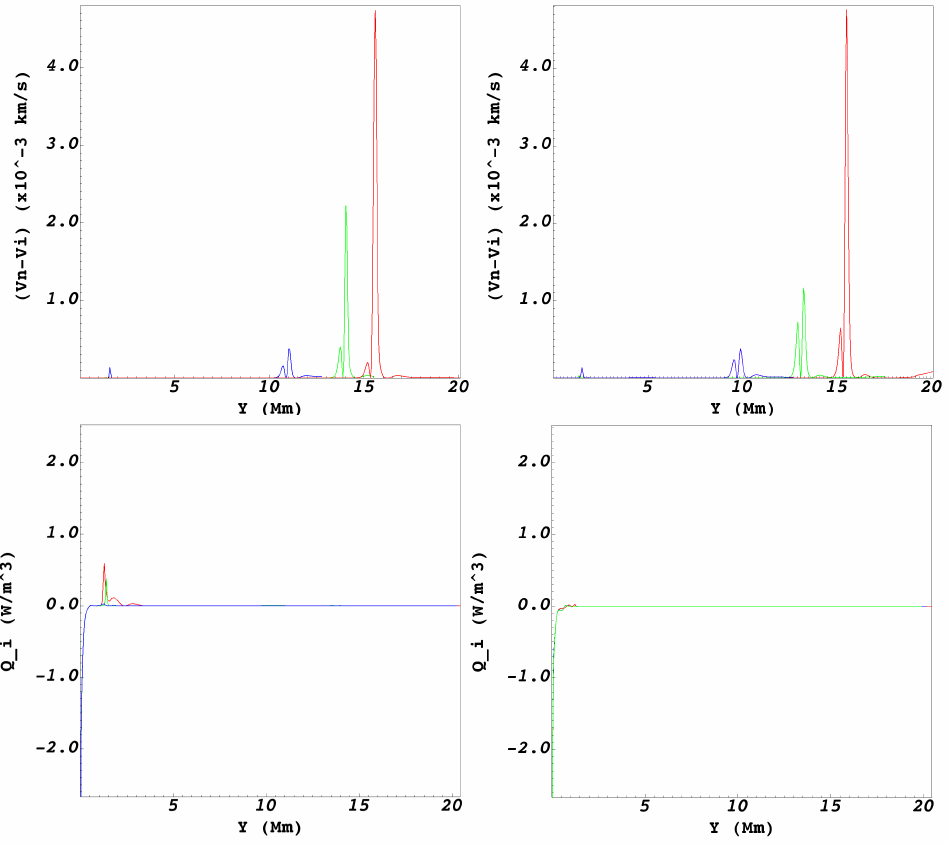
Figure 6. Upper : the difference between the neutral and ion speeds evaluated along x = 0, for Jet1 (red), Jet2 (green), and Jet3 (blue) at the corresponding y max values for the uniform ( left ) and flux tube ( right ) magnetic fields. Lower: the heat Q i , n , generated by the interaction between fluids evaluated i along x = 0 for Jet1 (red), Jet2 (green), and Jet3 (blue) at the corresponding t y values for the uniform max ( left ) and flux tube ( right ) magnetic